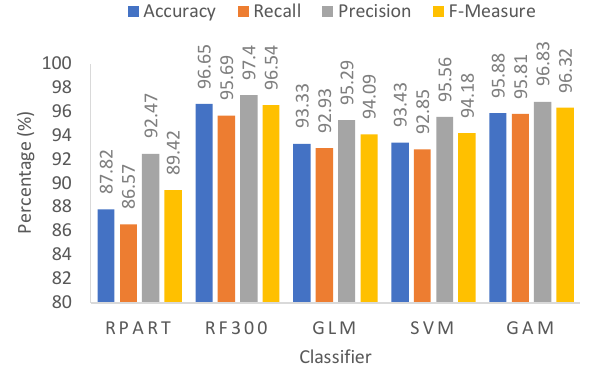
Figure 3. Classifiers Performance Metrics